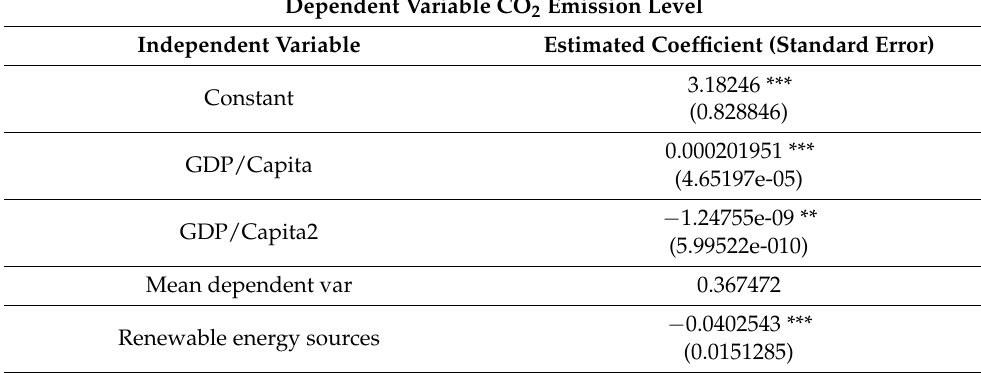
Table 5. Cross-sectional regression analysis